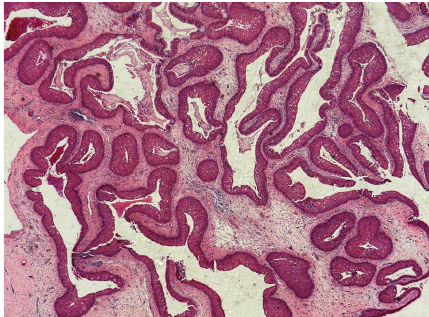
Figure 2: Typical histopathological features of the inverted Schnei- derian papilloma showing endophytic growth of pseudostratified ciliated epithelium forming cystic spaces (H.E—25x).